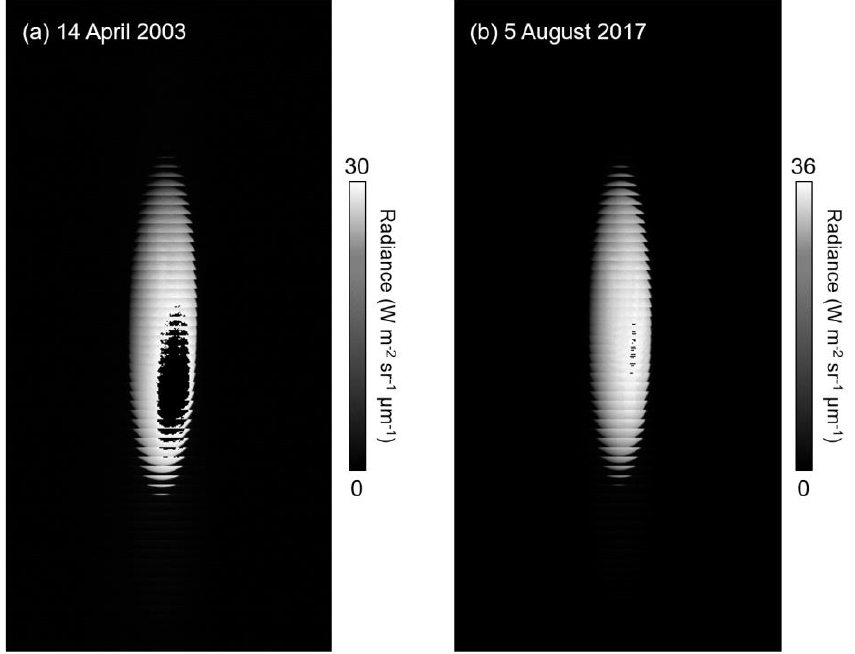
Figure 2. Images of the Moon taken by the TIR Band 10 on ( a ) 14 April 2003 and ( b ) 5 August 2017, whose oversampling effects were not corrected. Black pixels in the Moon disks indicate saturation due to the high temperature of the Moon that exceeds the observable range of the band.